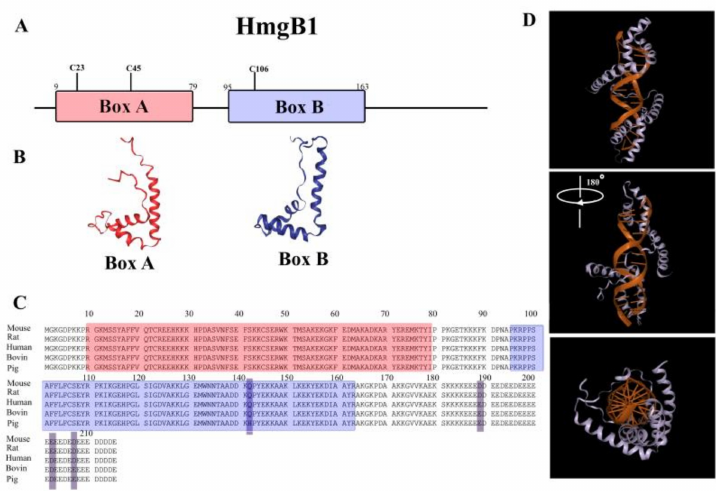
Figure 1. The structure of HmgB1 protein. ( A ) Schematic representation of the structure of chromatin non-histone protein HmgB1. The Box A and Box B are marked by red and blue, respectively; ( B ) the 3D-structure of HMGB domains of HmgB1; ( C ) the amino acid sequence of HmgB1 from mouse, rat, human, bovine, and pig (color scheme as in A); ( D ) The model of interaction of the linked two HMGB domains with DNA. The figure is based on PDB (1AAB, 2GZK) and Uniprot data (P63159; P63158; P09429; P10103;